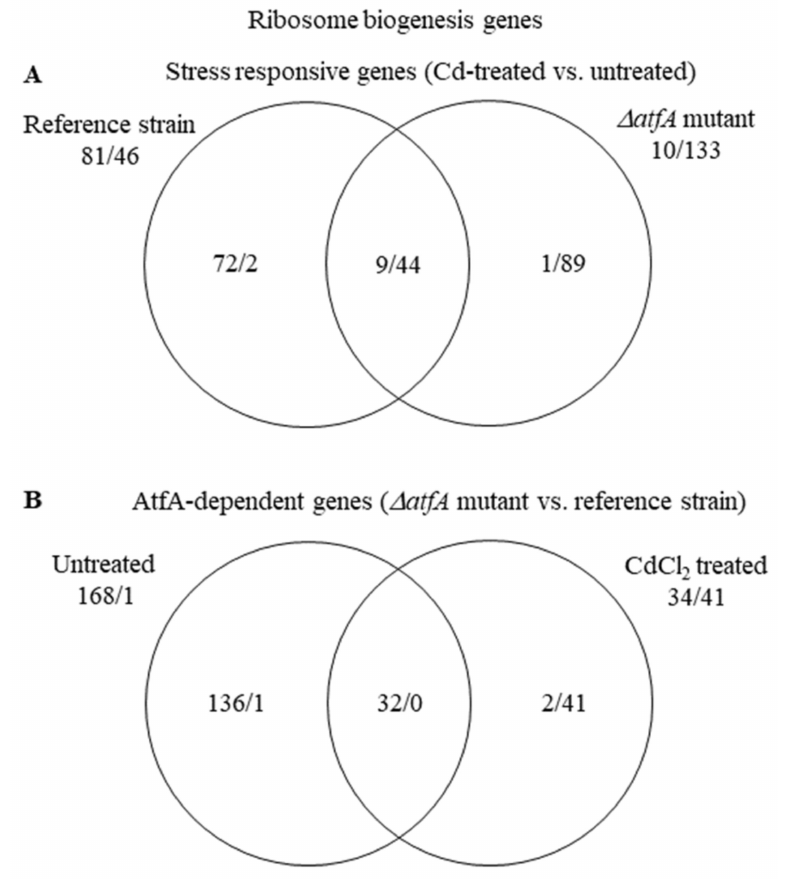
Figure 5. Distribution of stress responsive “Ribosome biogenesis” genes between the THS30 reference strain and the TNJ92 ∆ atfA mutant ( A ) as well as of the AtfA-dependent “Ribosome biogenesis” genes between the untreated and CdCl 2 -treated cultures ( B ). Figures represent the number of up- regulated/down-regulated genes. Further data on the gene group are available in Table